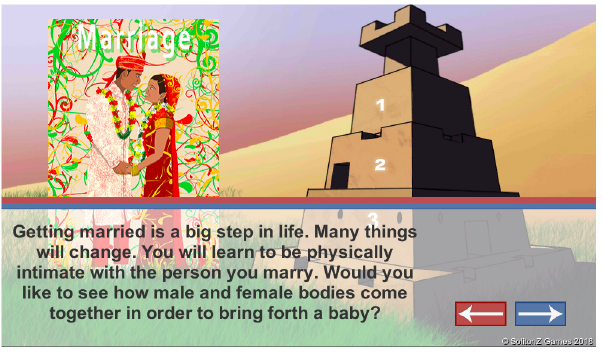
intercourse.Figure 1. Consent screen from Getting Married